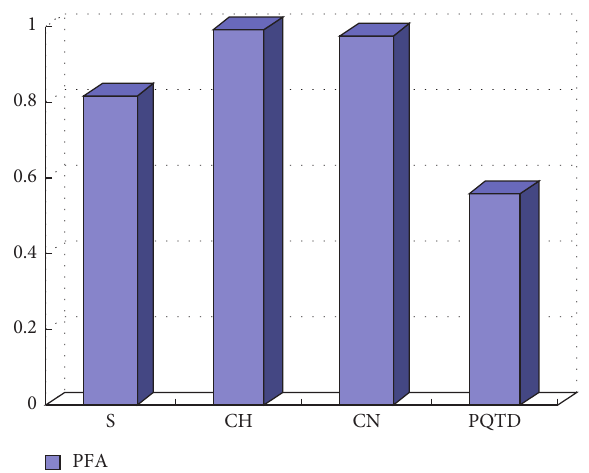
Figure 2: Pearson correlation coefficient of the PFA algorithm.